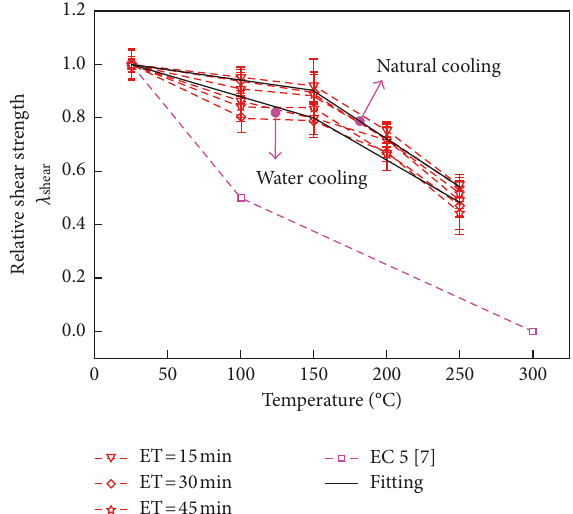
Figure 11: Variation of relative residual shear strength parallel to grain with temperature and cooling methods (ET